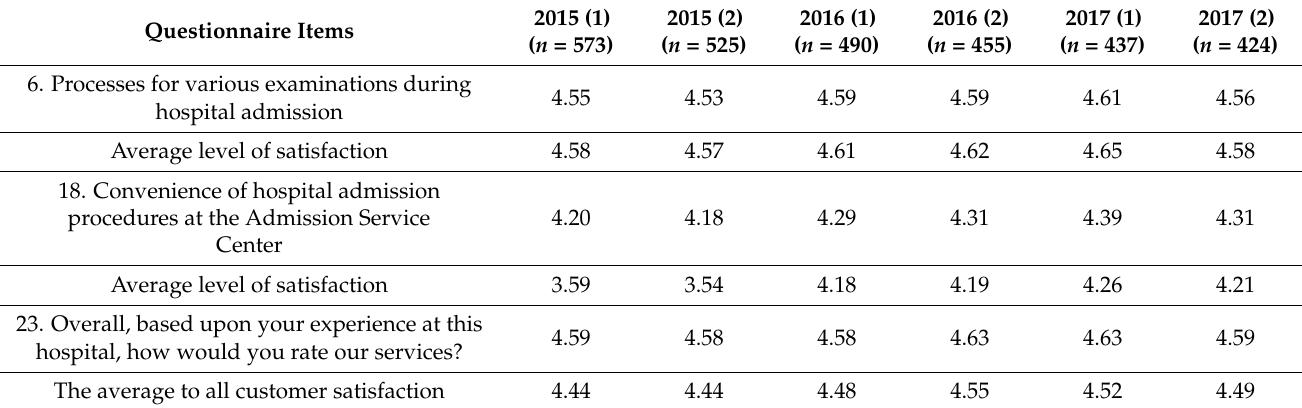
Table 1. Inpatient Satisfaction Survey Report during the years 2015 to